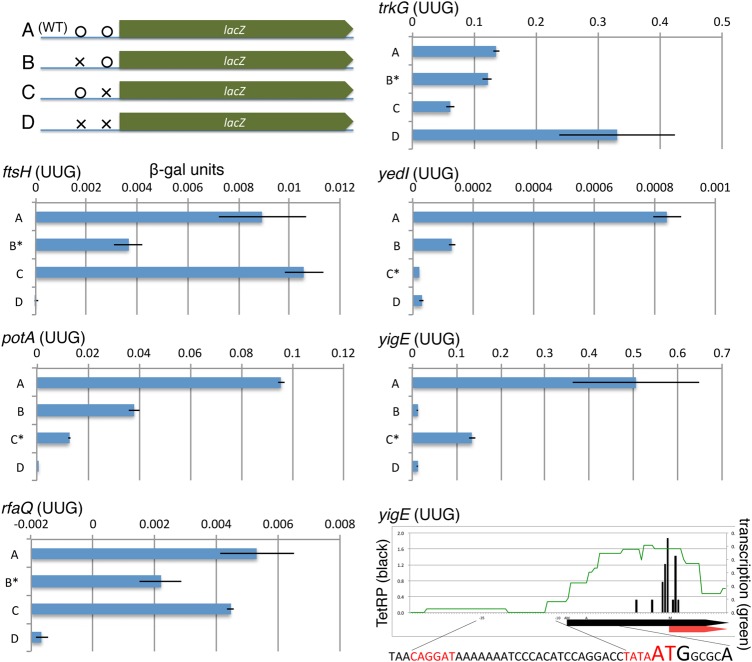
β-Galactoside activity from lacZ reporter gene fusions. Results from fusions to initiation regions (A) with both possible translation initiation codons (wild type), (B) with upstream initiation codon mutated, (C) with downstream initiation codon mutated, and (D) with both initiation codons mutated. The construct with the new annotated initiation codon mutated is marked with an asterisk. Upper left panel shows the structures of the gene fusions with an X marking mutated sites. Lower right panel shows TetRP (black), transcription (gray), and DNA sequence near the yigE initiation codon. -35 and -10 regions of the possible promoter are highlighted (red). The 2006 ATG initiation codon and transcription start site are enlarged. This figure is available in black and white in print and in colour at DNA Research online.